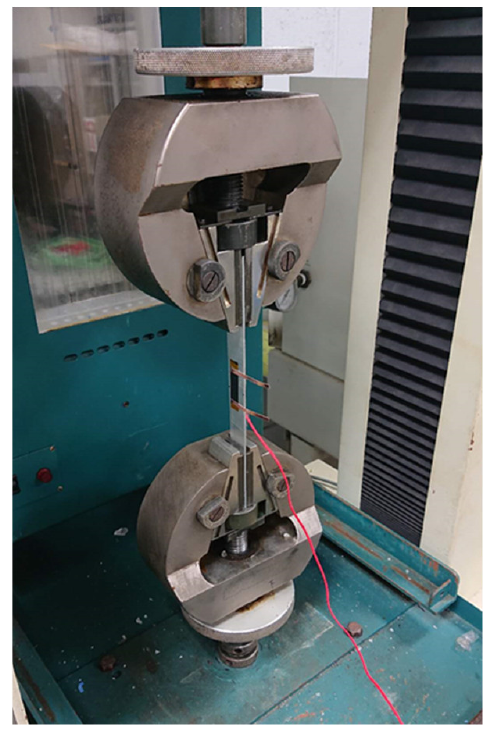
Figure 12. Al specimen subjected to tensile loading.